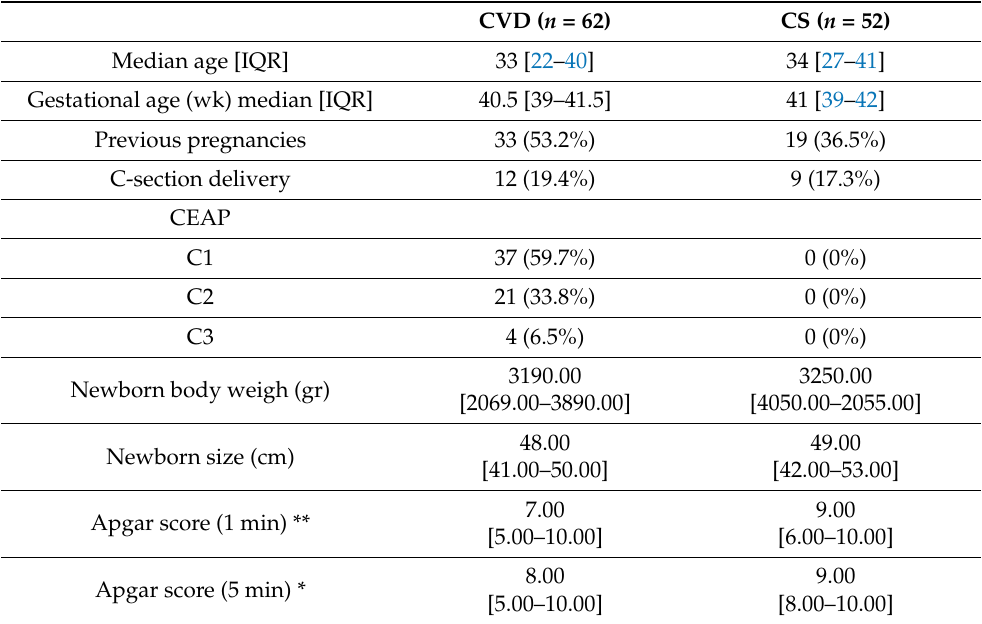
Table 1. Demographics and clinical characteristics of pregnant women and newborns of women diagnosed with chronic venous disease during pregnancy (CVD) and Control without venous pathology (CS), gr = grams, cm = centimetres, p < 0.05 (*) and p < 0.01 (**). CVD ( n = 62) CS ( n =